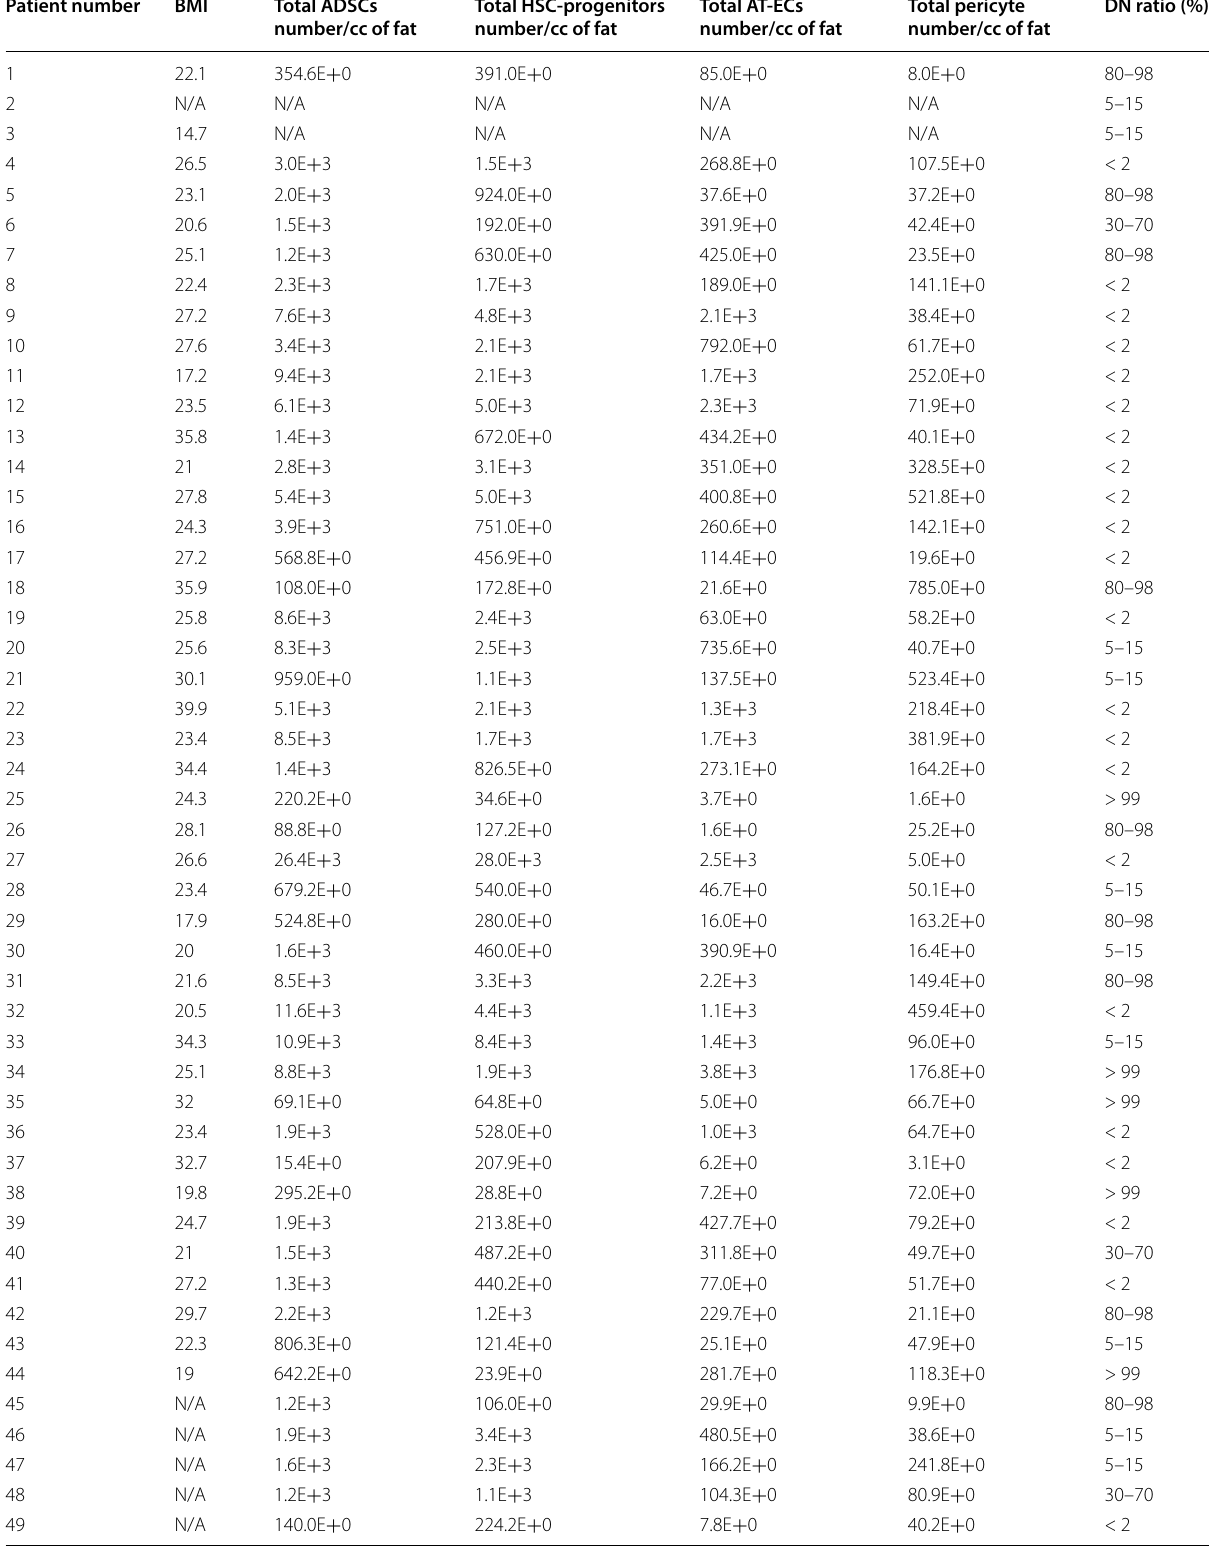
Table 2 The absolute number of isolated cell subsets in 44 non-cancer and 14 cancer